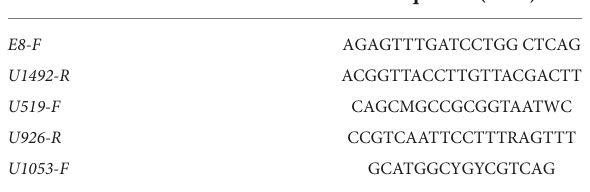
TABLE 1 Universal and intermediate primers used in 16S rDNA amplification.